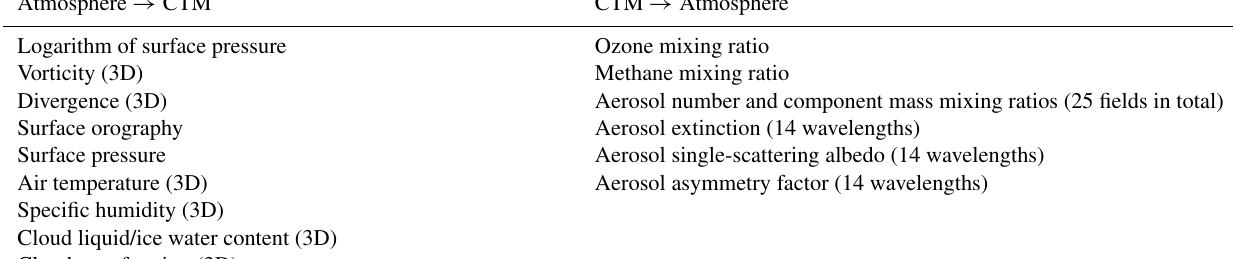
Table 7. Variables exchanged with a 6h frequency between the atmosphere and the chemical transport model (CTM) TM5 in EC-Earth3- AerChem. Atmosphere → CTM CTM → Atmosphere Logarithm of surface pressure Ozone mixing ratio Methane mixing ratio Aerosol number and component mass mixing ratios (25 fields in total) Surface orography Aerosol extinction (14 wavelengths) Surface pressure Aerosol single-scattering albedo (14 wavelengths) Aerosol asymmetry factor (14